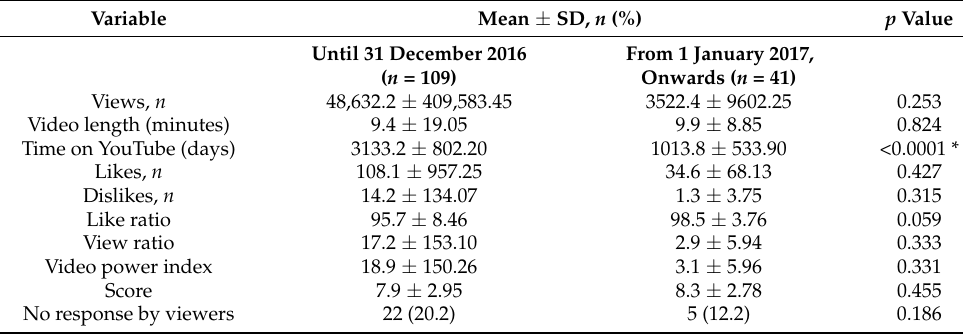
Table 5. Comparison of the time of video upload to